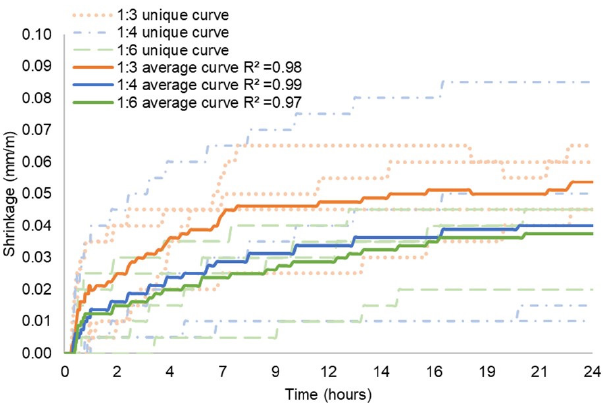
Figure 11. Early shrinkage curves of cement mortars sealed with PVC film. NOTE: dotted lines indicate individual tests, continuous ones are their respective average curves and their legend contains their linear R used to find shrinkage